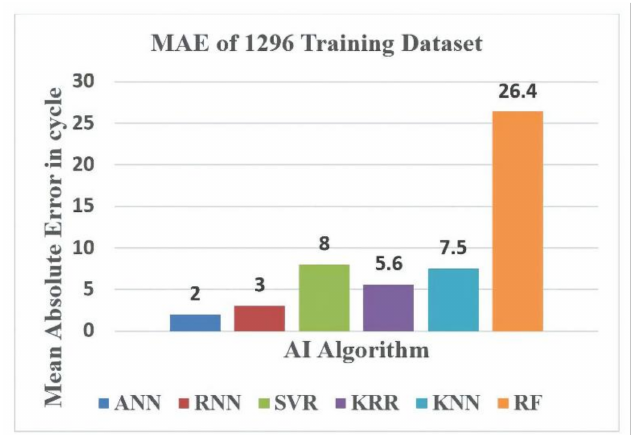
Figure 16. MAE analysis vs. AI model for 1296 training